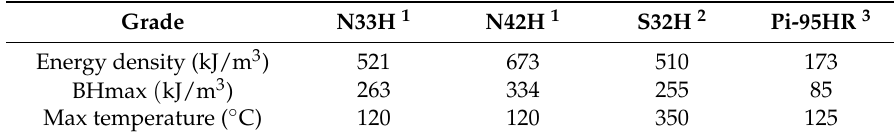
Table 1. Overview of considered permanent magnet materials.